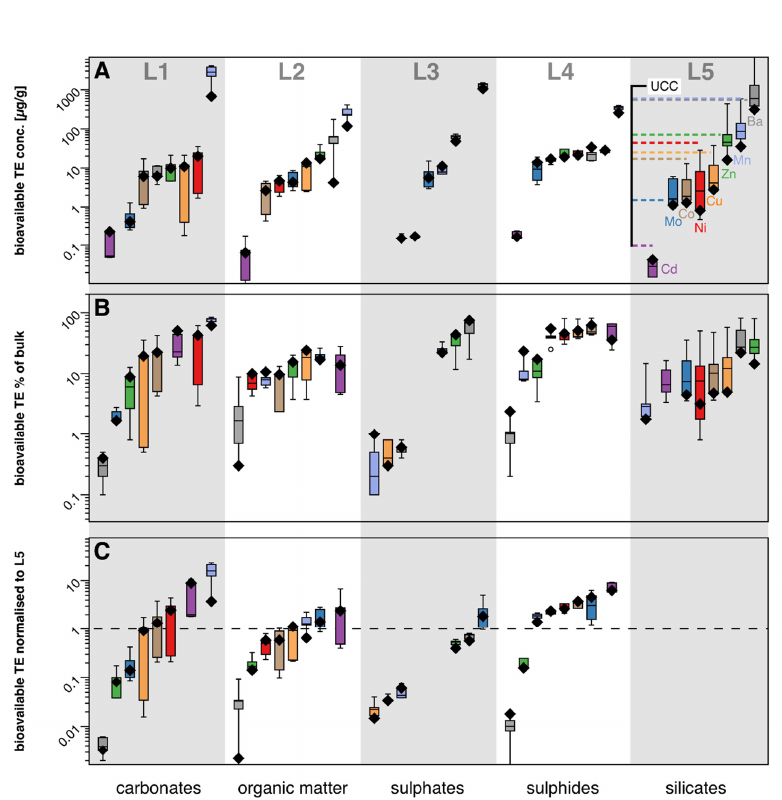
Figure 3. ( A ) Whisker plots of obtained bioavailable metal concentrations on five di ff erent leachates (L1, L2, L3, L4, L5) from mixed lithologies, relative to the respective mineral / authigenic phases being leached. The diamonds represent the composition of the black shale sample SMS-1 studied. The dashed lines in L5 represent average upper continental crust (UCC) concentrations of the respective elements [77]; all whiskers are sorted to ascending median values, colours refer to elements as obtained in L5. ( B ) Whisker plots of obtained bioavailable metal concentrations on five di ff erent leachates (L1, L2, L3, L4, L5) from mixed lithologies, as percentage of the bulk samples concentration of the respective element. ( C ) Whisker plots of obtained bioavailable metal concentrations on four di ff erent leachates (L1, L2, L3, L4) from mixed lithologies normalized to concentrations obtained in L5 representing a total digestion of the detrital minerals as analogue for the hinterland weathering input of trace metals in the restricted Nanhua